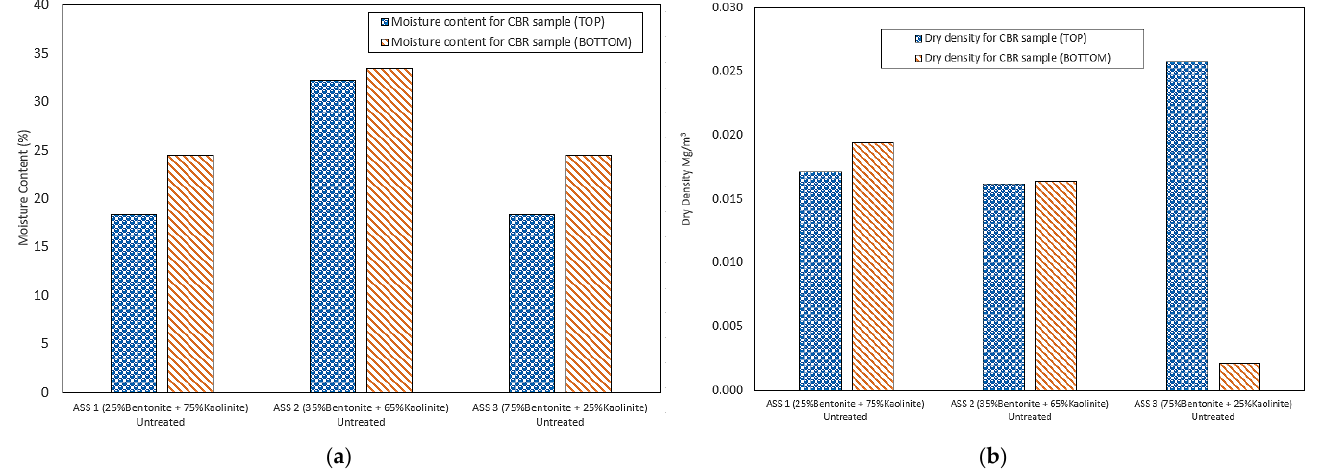
Figure 9. ( a ) Moisture content for the top and bottom of the CBR samples; ( b ) dry density for the top and bottom of the CBR samples.